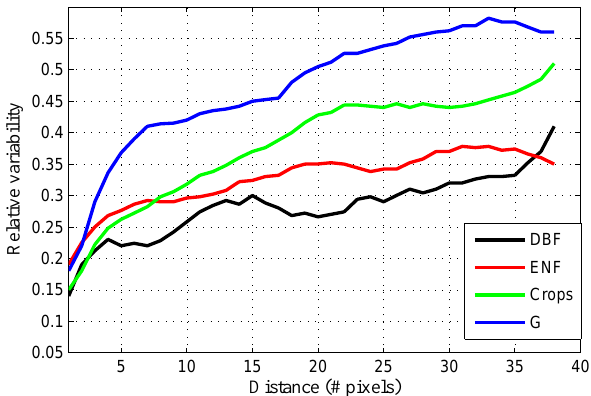
Fig. 14. Relative variability of LAI with distance (# pixels) to near- est homogeneous pixel, by PFT, i.e. C3 crops (black), DBF (red), ENF (blue), G (green), in Europe. A sliding average window of 5 distance units has been applied to the curve.